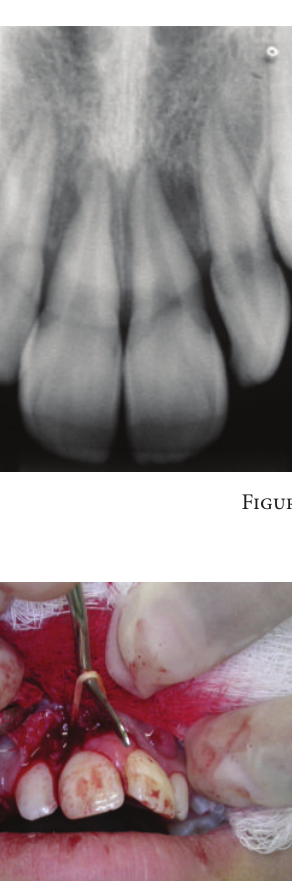
Figure 1: Initial clinical findings and elastic artifact.